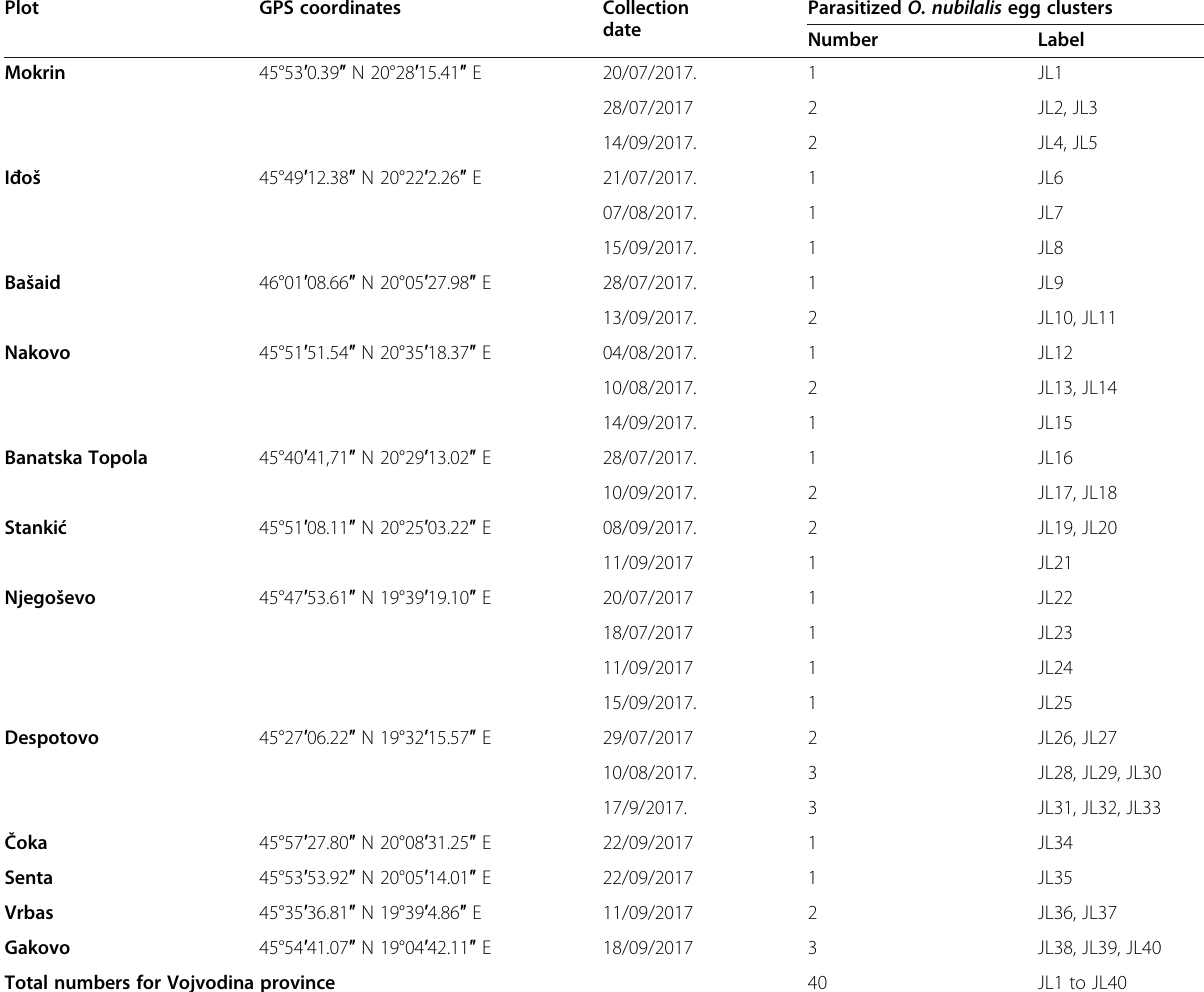
Table 2 Data for forty samples of Serbian corn crops taken in search of parasitized ECB egg masses. For each sample, 100 randomly selected plants of corn were inspected